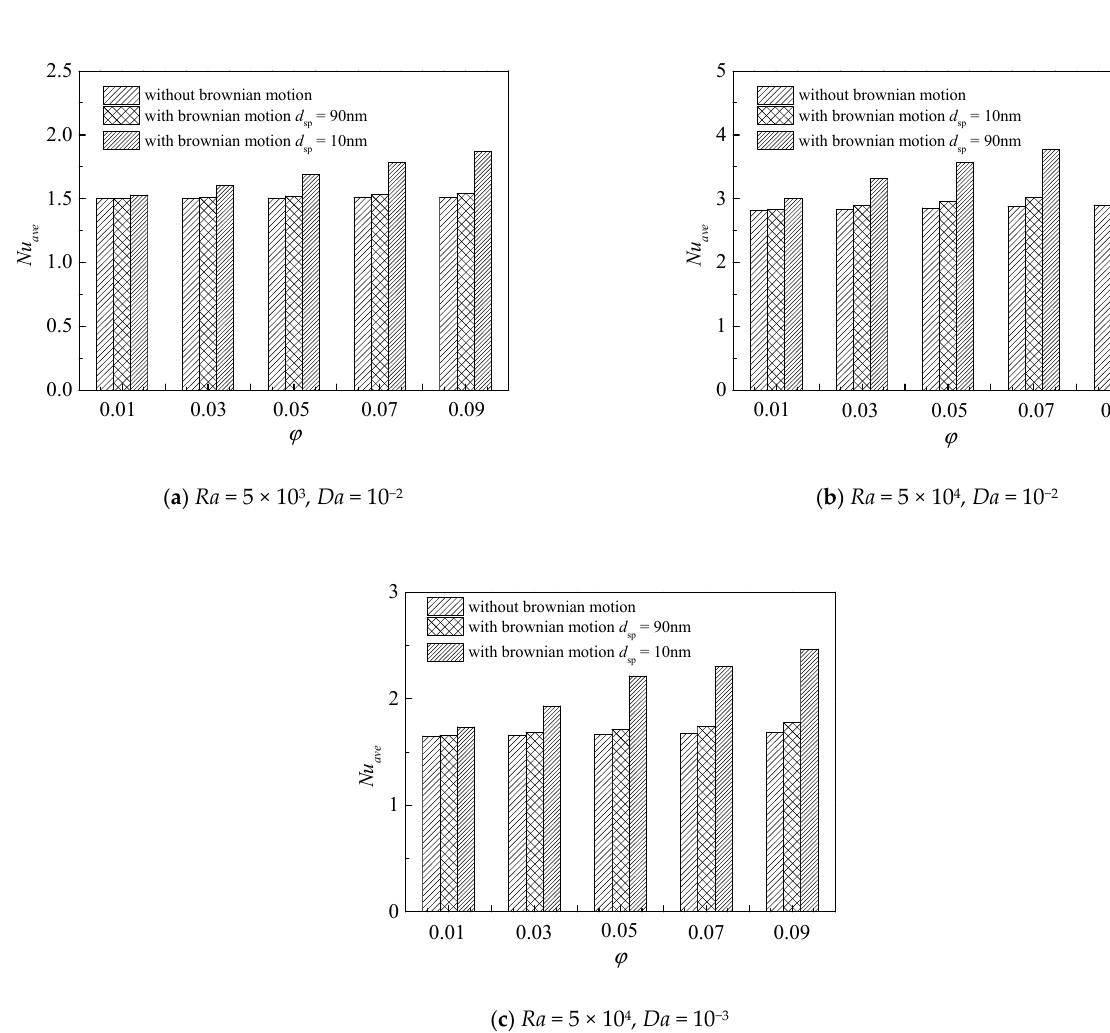
Figure 3. Effects of Brownian motion on the average Nusselt number ( Nu avg ) along the inner wall for different nanoparticle volume fractions ( ϕ ) and nanoparticle diameters ( d sp ) at ε = 0.5, RR = 2, and ( a ) Ra = 5 × 10 3 , Da = 10 − 2 , ( b ) Ra = 5 × 10 4 , Da = 10 − 2 , ( c ) Ra = 5 × 10 4 , Da = 10 − 3 .